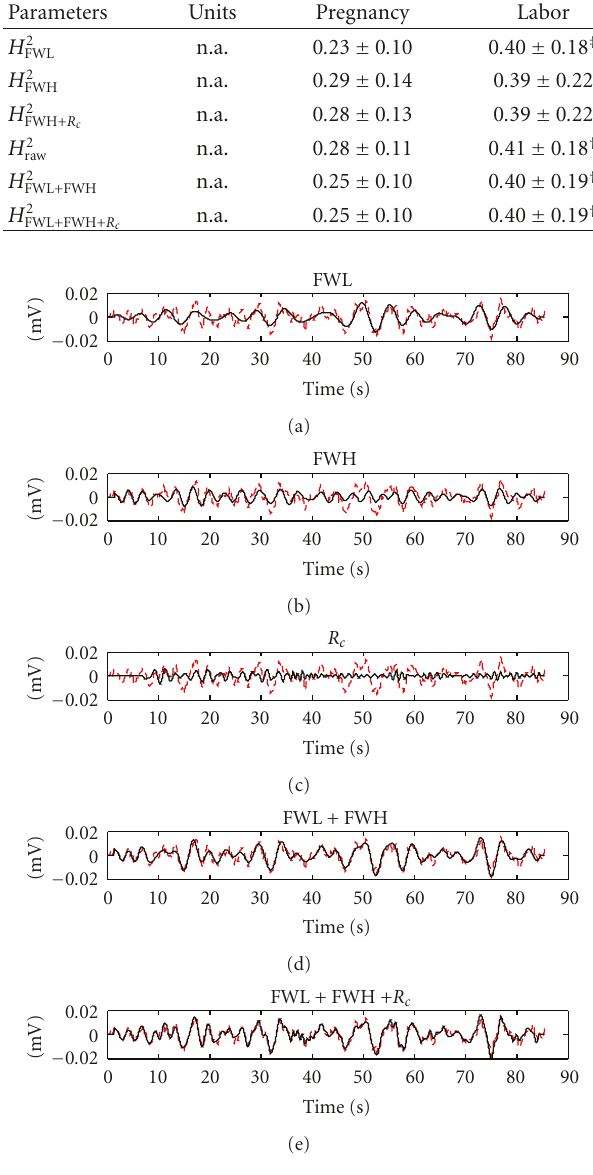
Figure 5: Example of ridge reconstruction of FWL, FWH and R c for a pregnancy contraction. The two last panels represent the reconstructed contraction defined as the sum of FWL and FWH or FWL, FWH and a third ridge R c